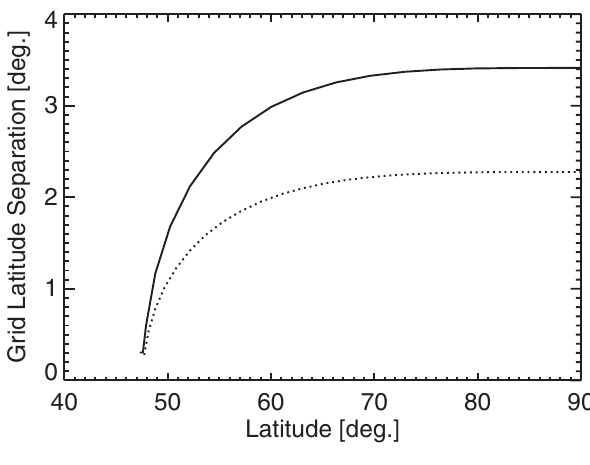
Fig. 11. Latitude separation of the grid points along the dawn–dusk (solid line) and noon–midnight (dotted line) meridian as a function of geomagnetic